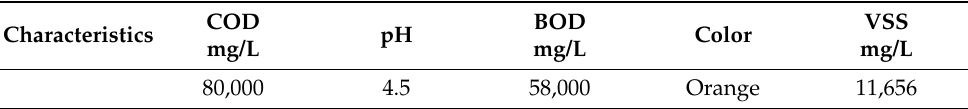
Table 4. Characteristics of industrial